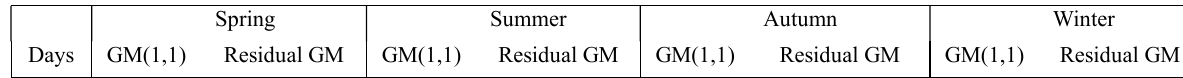
Table 1. Daily average relative accuracy of four models in low latitudes P